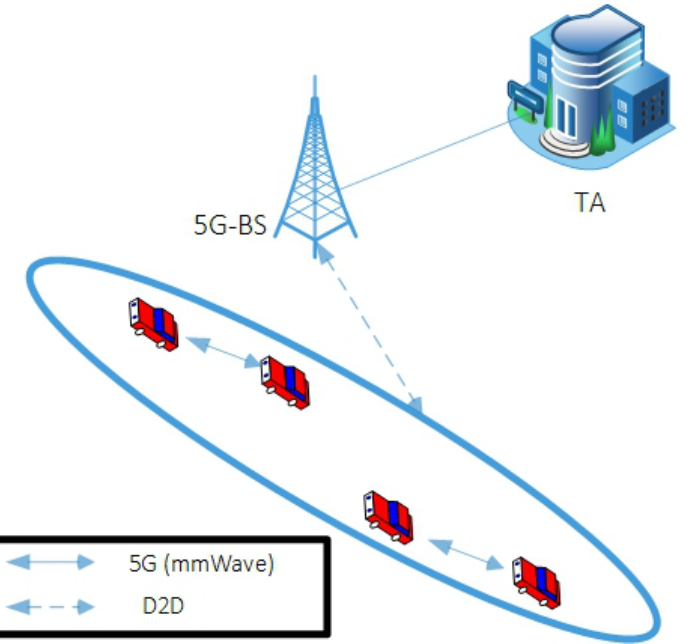
Figure 1. Network Structure of vehicular communication relying on 5G technology